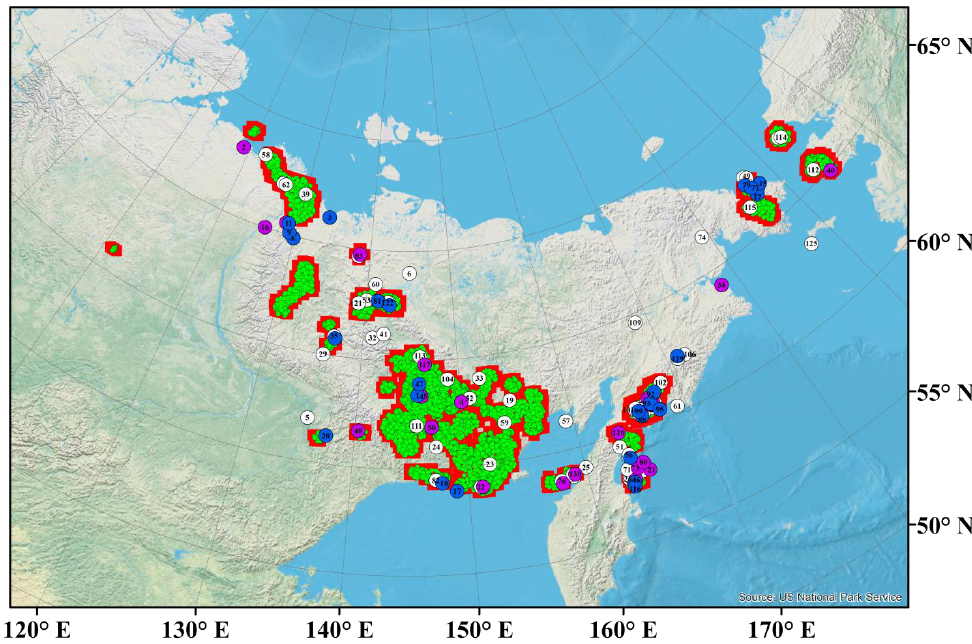
Figure 6. FCAZ zones prone to earthquakes (calculated at M R = 1.0) in the eastern sector of the Russian Arctic and earthquake epicenters with M ≥ 5.0. Designations as in Figure 3.